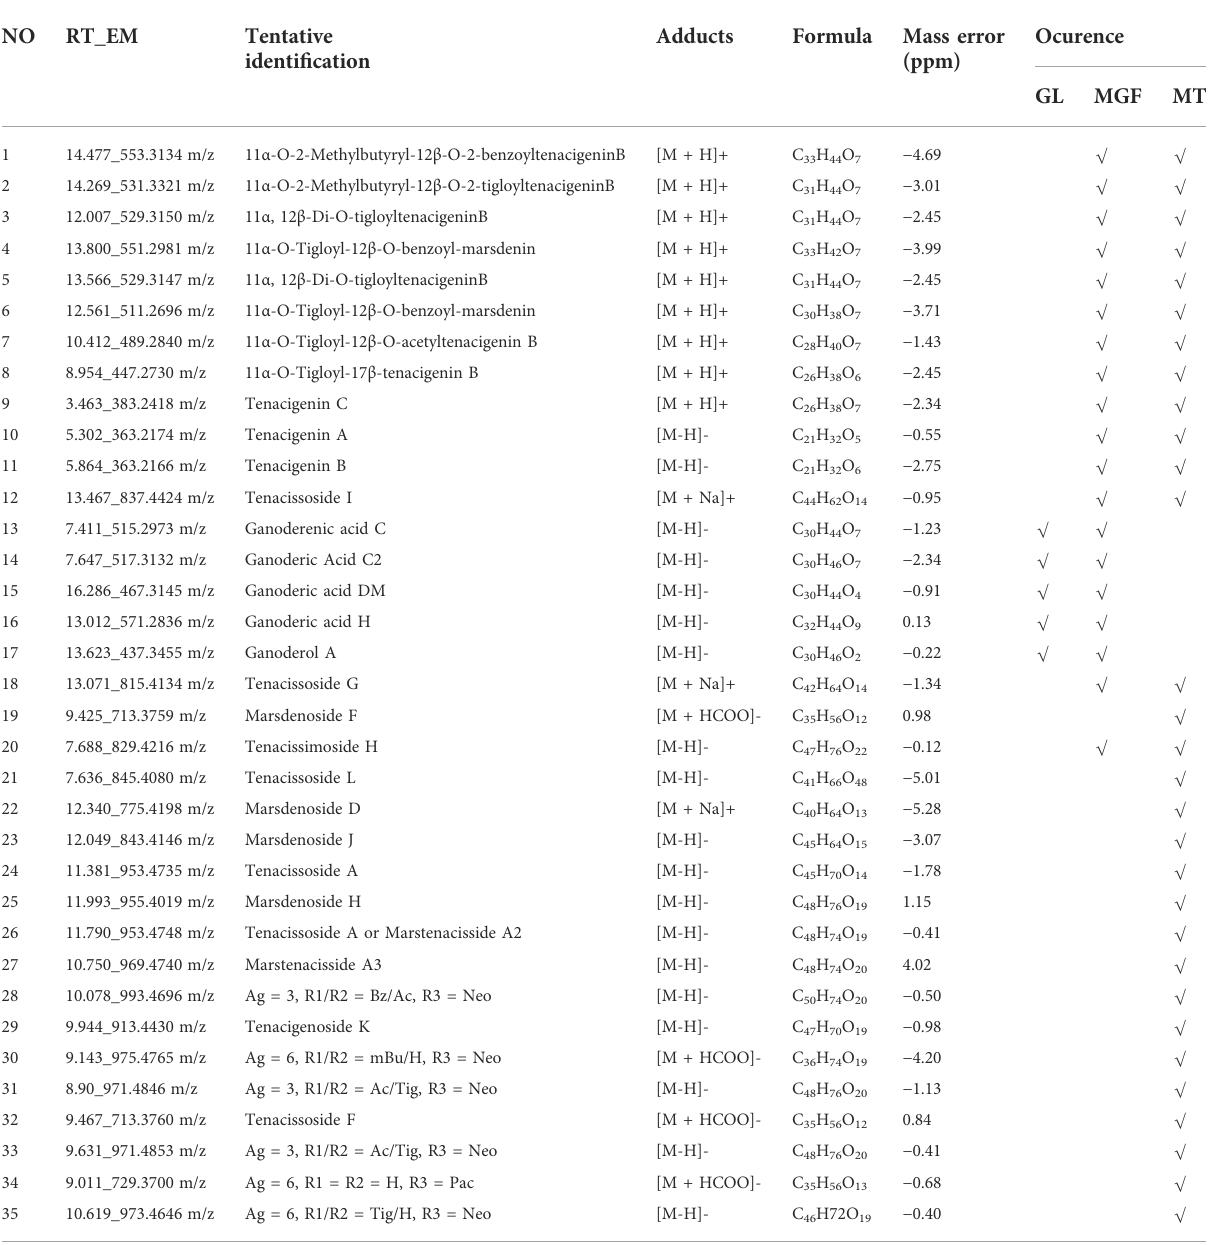
TABLE 1 Tentatively identi fi ed major metabolites of Marsdenia tenacissima (MT), Ganoderma lucidum (GL) and Marsdenia tenacissima with Ganoderma lucidum co-fermentation (MGF). NO RT_EM Tentative identi fi cation